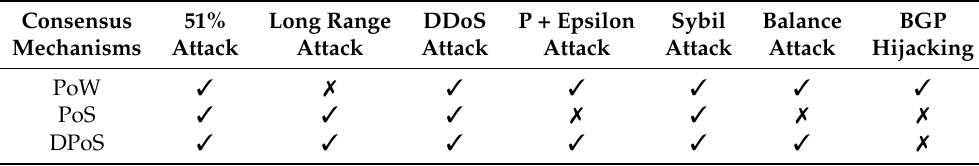
Table 2. Consensus mechanisms that are vulnerable to various